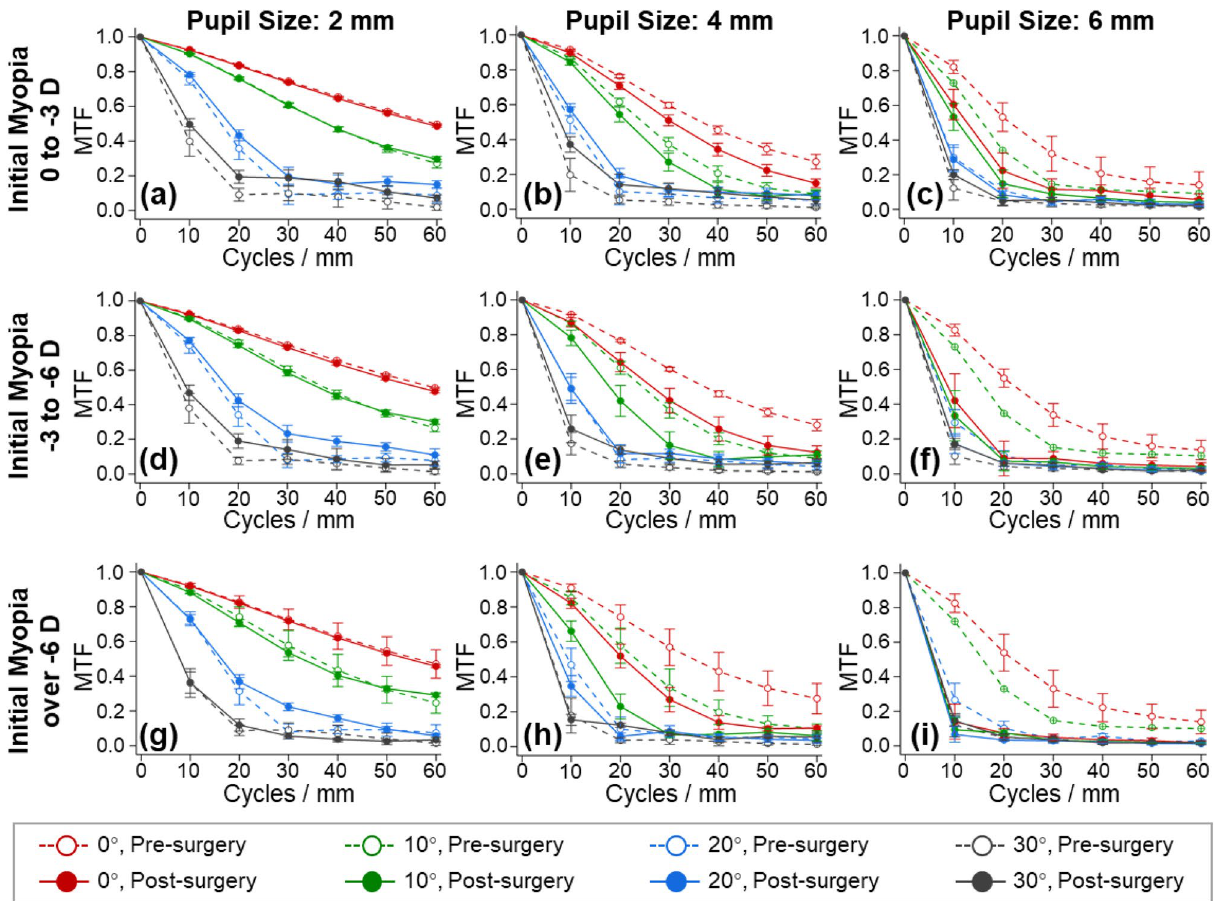
Figure 5. Polychromatic MTF analysis (mean ± SD) at the fields of 0°–30° at a maximum spatial frequency of 60 cycles per millimeter. The MTF values were averaged between the tangential and sagittal directions. ( a – i ) The MTF analysis at different pupil sizes (2 mm, 4 mm, and 6 mm) and for groups of different initial myopia, including mild myopia (0 to − 3 D), medium myopia (− 3 to − 6 D), and high myopia (over − 6